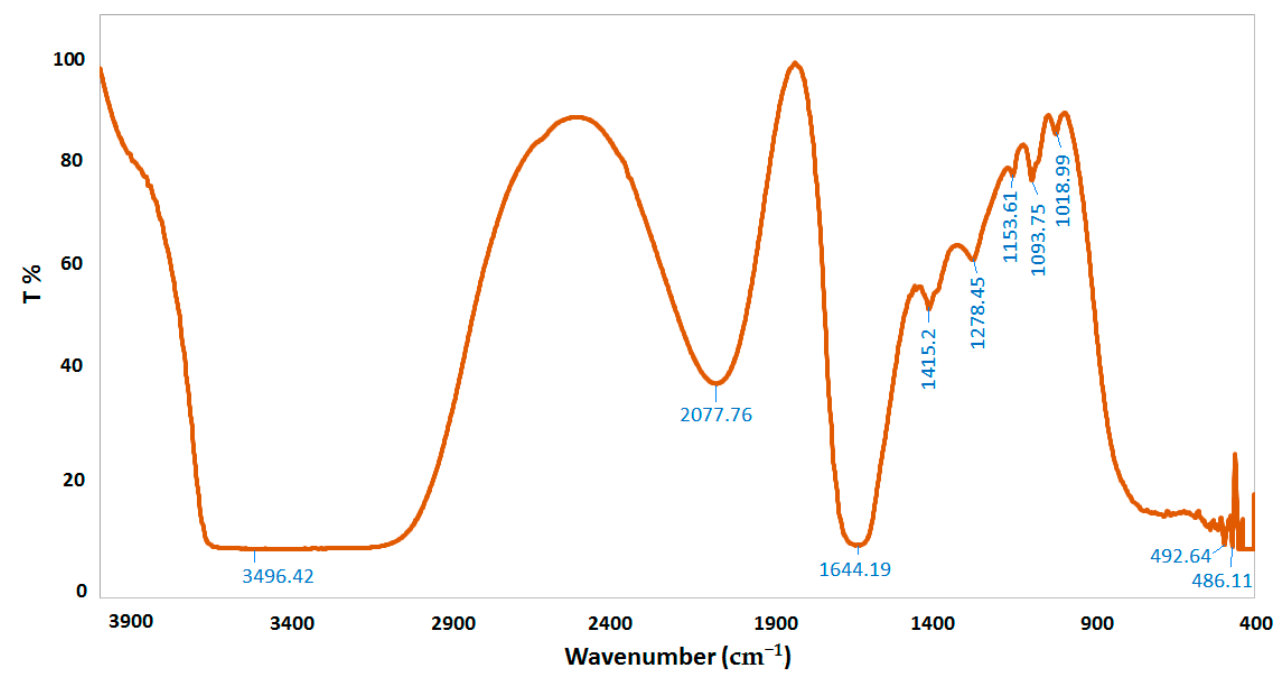
Figure 6. FTIR spectra of CSNPs.